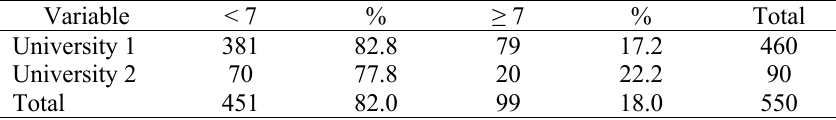
Table 2. SBQ-R Suicide Risk Rates (N =